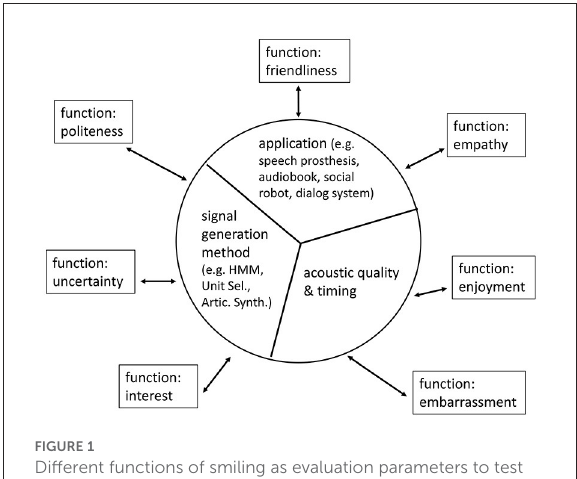
FIGURE1 Different functions of smiling as evaluation parameters to test the appropriateness of signal generation, application, acoustic quality, and